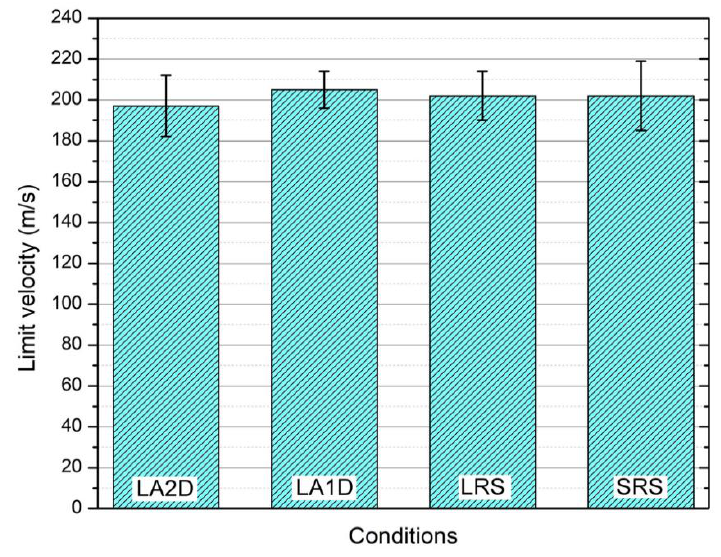
Figure 5. Limit velocity of different investigated conditions.